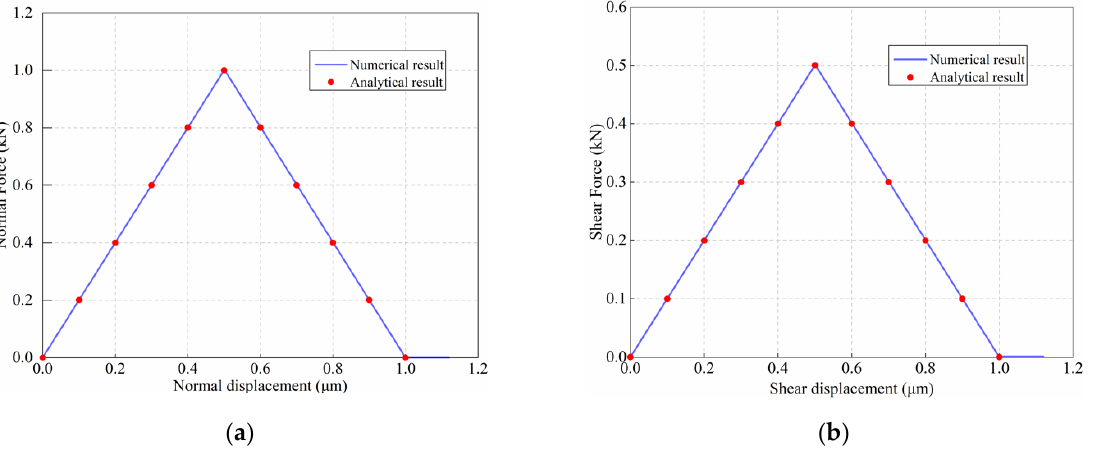
Figure 9. Comparison between analytical and numerical results of force – displacement curves: ( a ) Mode-I fracture; ( b ) Mode-II fracture.